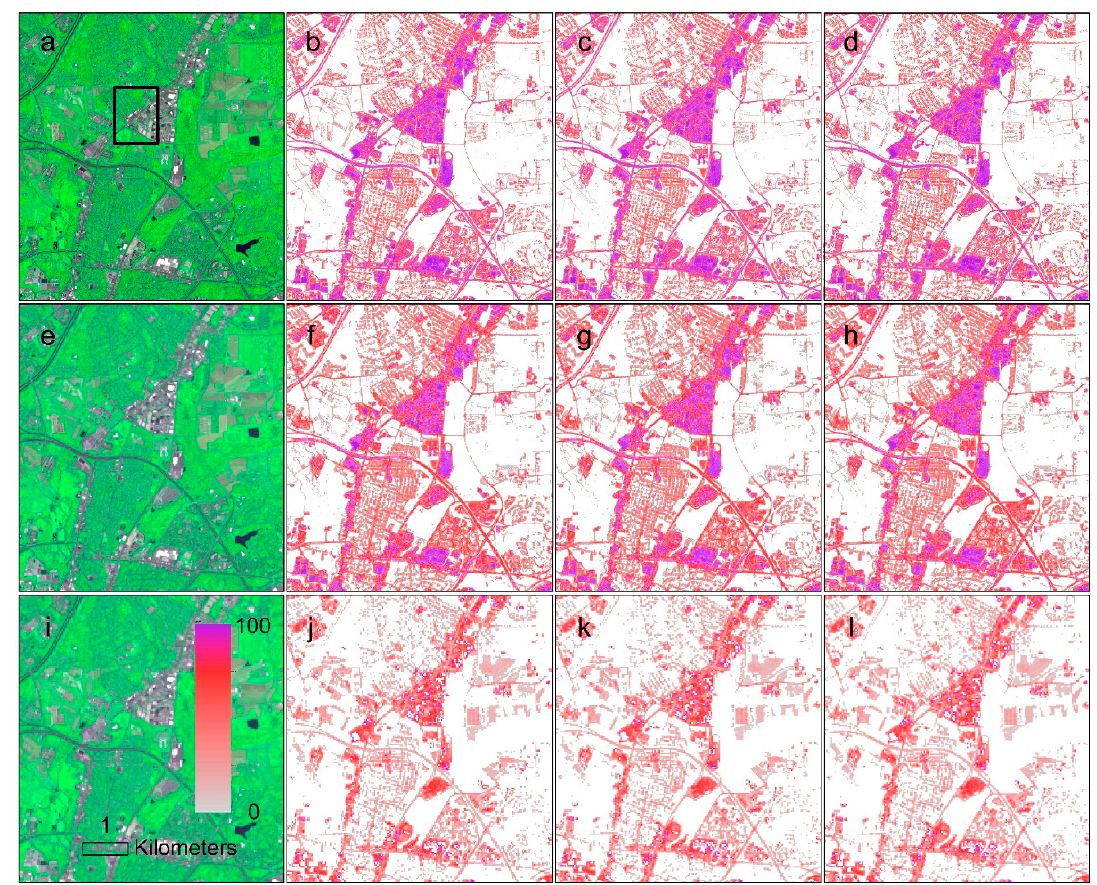
Figure 4. WV3 images ( a : 10 m, e : 20 m, i : 30 m; displayed using bands of R, NIR-1, G), and derived ISAs from images with half, three-quarters, and twice the Landsat OLI SNRs at 10 m ( b – d ), 20 m ( f – h ), 30 m ( j – l ) in Beltsville, Maryland. The non-ISAs are in white.